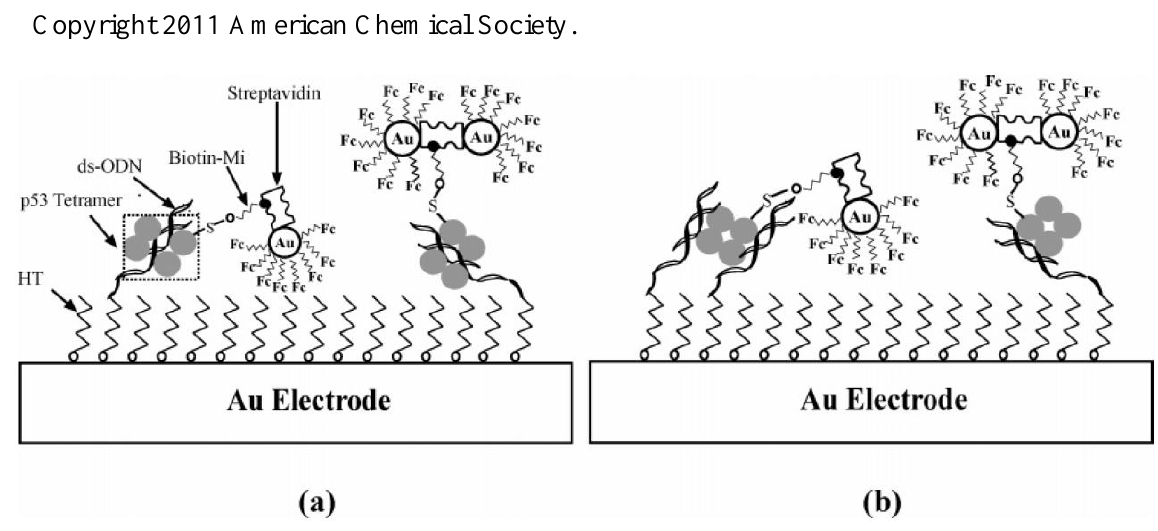
Figure 6. p53 protein sensors based on Fc-modified AuNP/streptavidin conjugates. ( a ) shows the most stable p53 binding mode on the sensor electrode; while ( b ) depicts two other possible binding configurations. Reprinted with permission from Zhou et al .